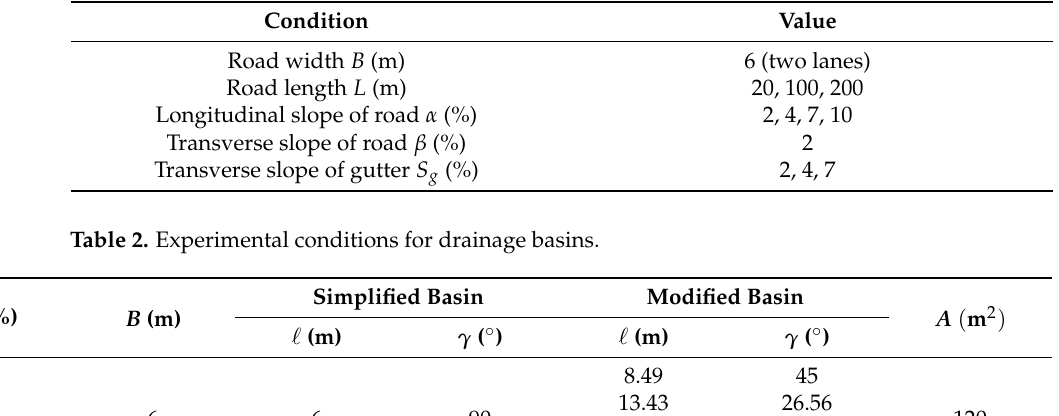
For the road surface-runoff analysis, the experimental conditions for roads were set to the values listed in Table 1 based on the road design criteria [22,23,37,38] and a previous study [21]. The experimental conditions for the drainage basin were selected as listed in Table 2 by applying the slope-dependent travel length, which was calculated using the road width and the longitudinal and transverse slopes of the road with Equations (5) and (7), respectively. Table 1. Experimental conditions for roads.